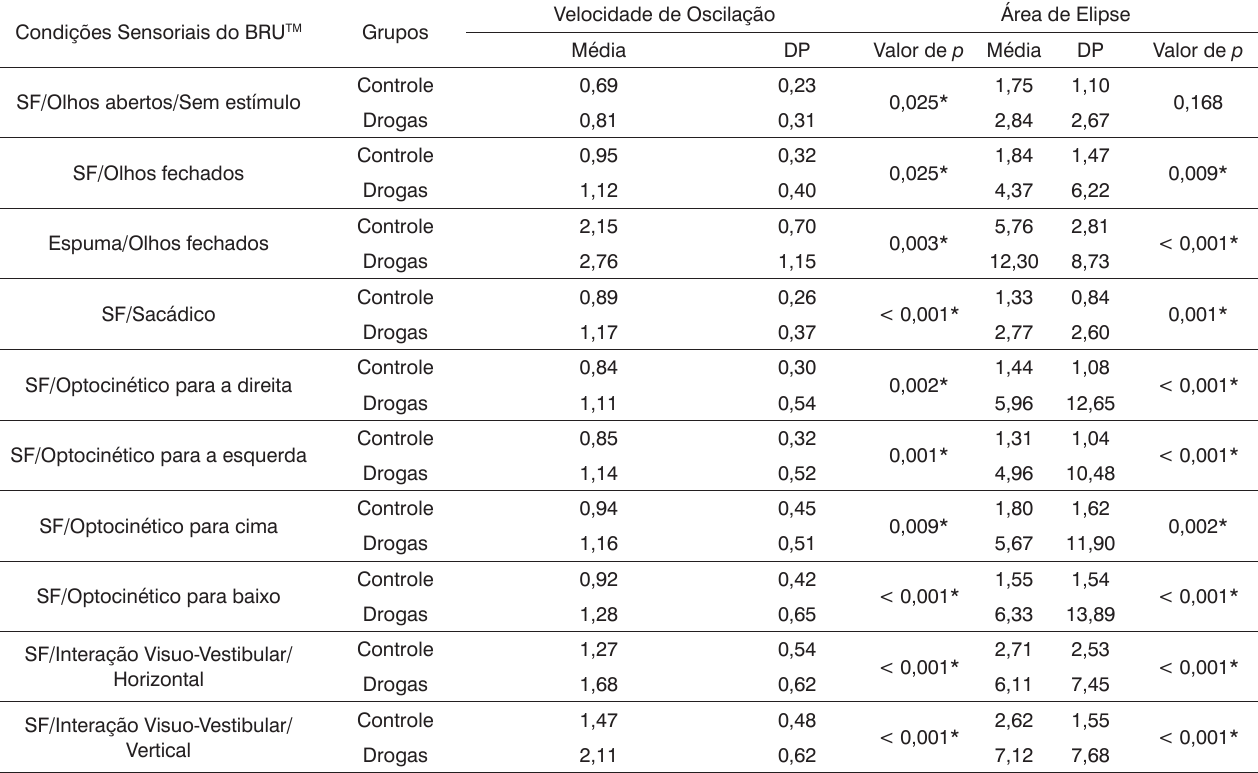
Tabela 1. Valores descritivos e análise comparativa da velocidade de oscilação (cm/s) e da área de elipse (cm 2 ) das